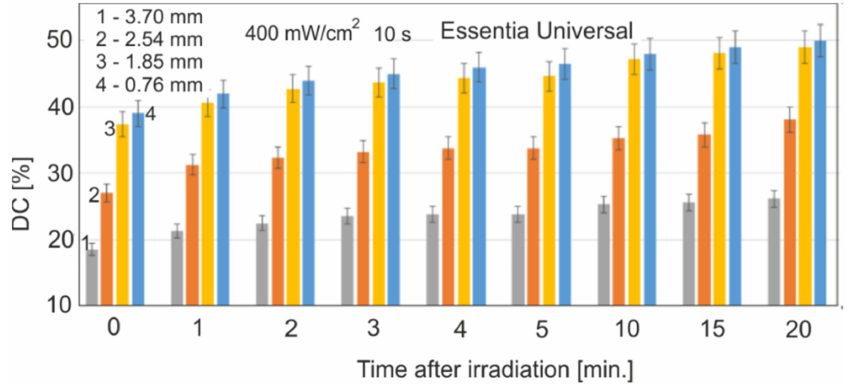
Figure 3. Influence of the sample thickness on the DC